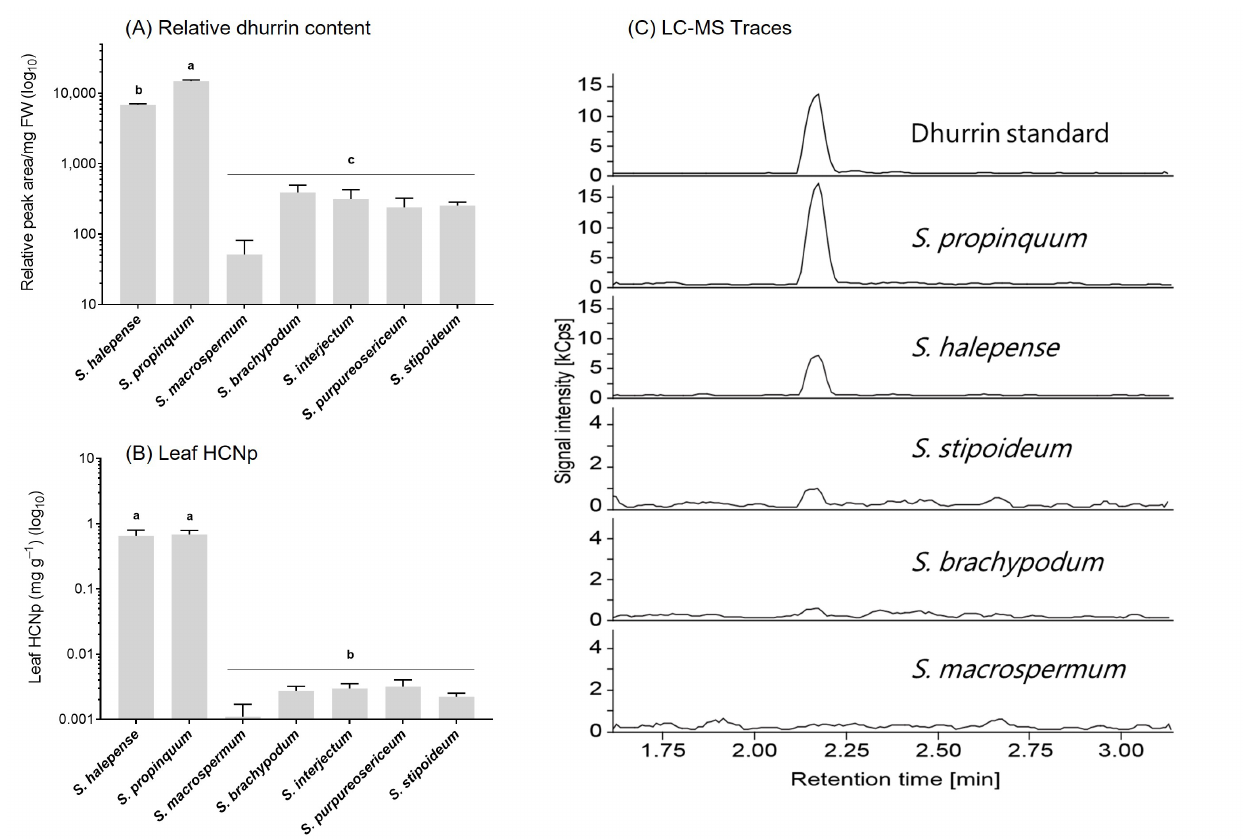
Figure 3. Relative dhurrin content and hydrogen cyanide potential (HCNp) in the youngest mature leaf of seven Sorghum species at 6 weeks post-germination plotted on a logarithmic scale. ( A ) Relative dhurrin content based on LC-MS analyses. ( B ) Leaf HCNp. ( C ) Selected LC-MS spectra from wild sorghum species depicting the differences in signal intensity of the base peak upon analysis of the same amount of fresh-frozen leaf material (RT dhurrin: 2.17 min; dhurrin parent ion at 307.1 (M- 27+Na), diagnostic fragments at m / z 212.1, 185.0 and 145.0 with the m / z 185.0 fragment representing the base peak). Graphs show mean ± 1 SE ( n = 3). Columns with different letters are statistically significant ( p <